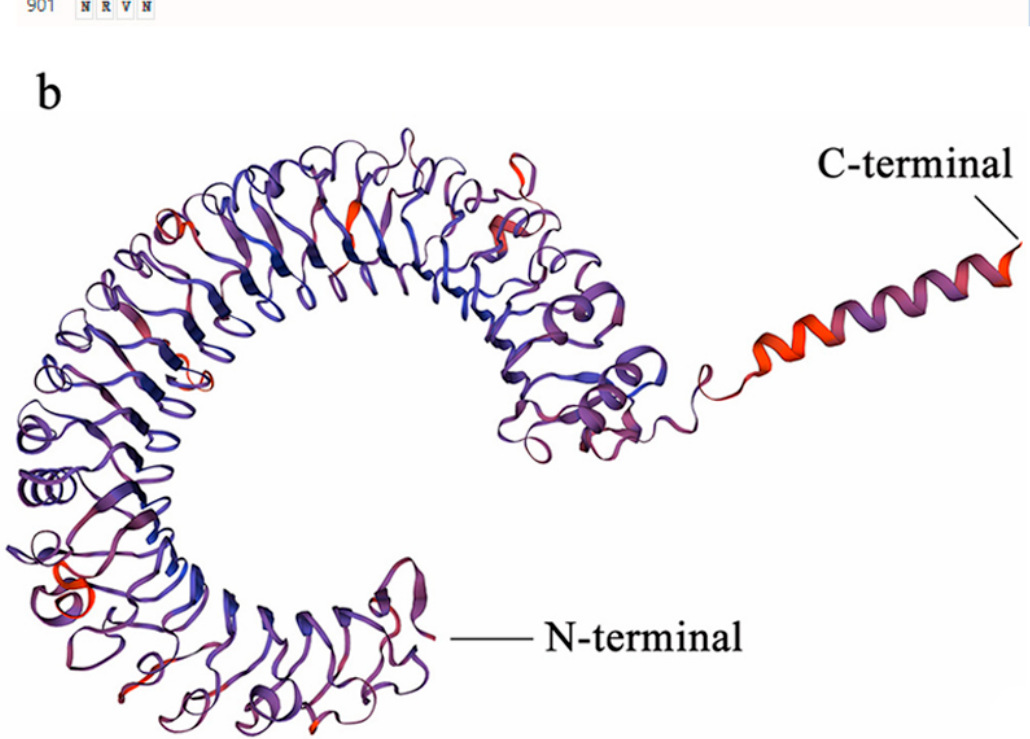
Figure 3. Predicted secondary structure and 3D structural models of Sp TLR3 protein. ( a ) Predicted secondary structure of Sp TLR3 protein. (cid:4) indicates helix, (cid:3) indicates coil, (cid:4) indicates strand. ( b ) Three-dimensional model structures of predicted Sp TLR3